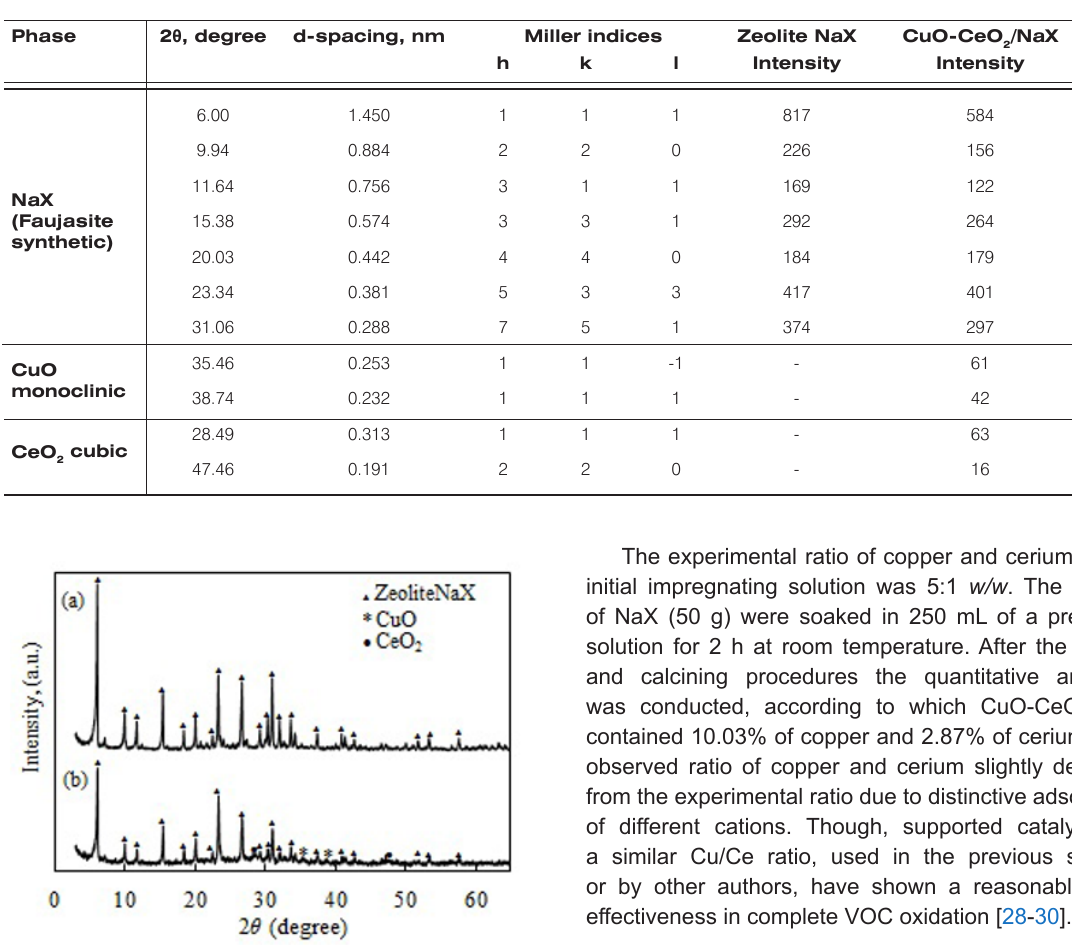
Table 1. Phase composition and diffraction peaks properties of zeolite NaX and dual function adsorbent-catalyst CuO-CeO